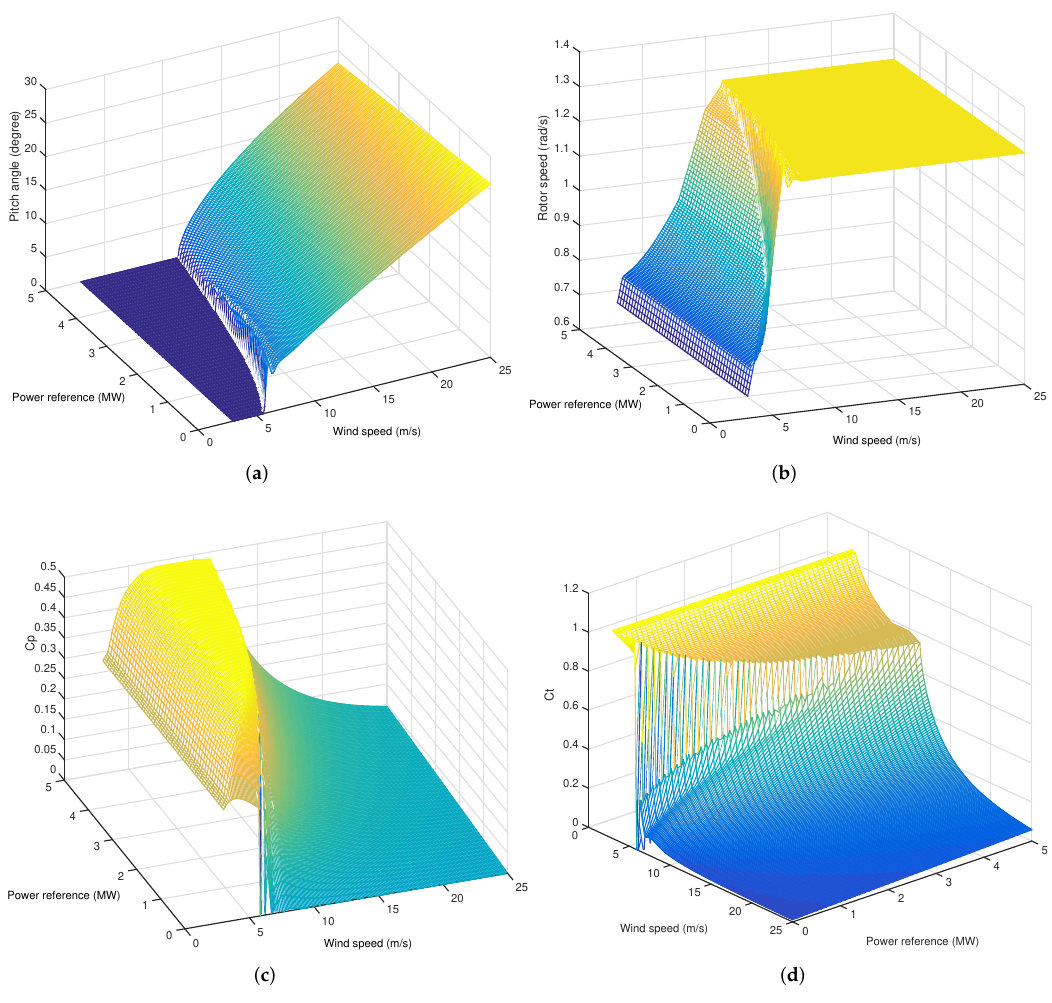
Figure 4. Operation state of WT in the maximum ω down-regulation strategy: ( a ) Pitch angle surface. ( b ) Rotor speed surface. ( c ) C p surface. ( d ) C t